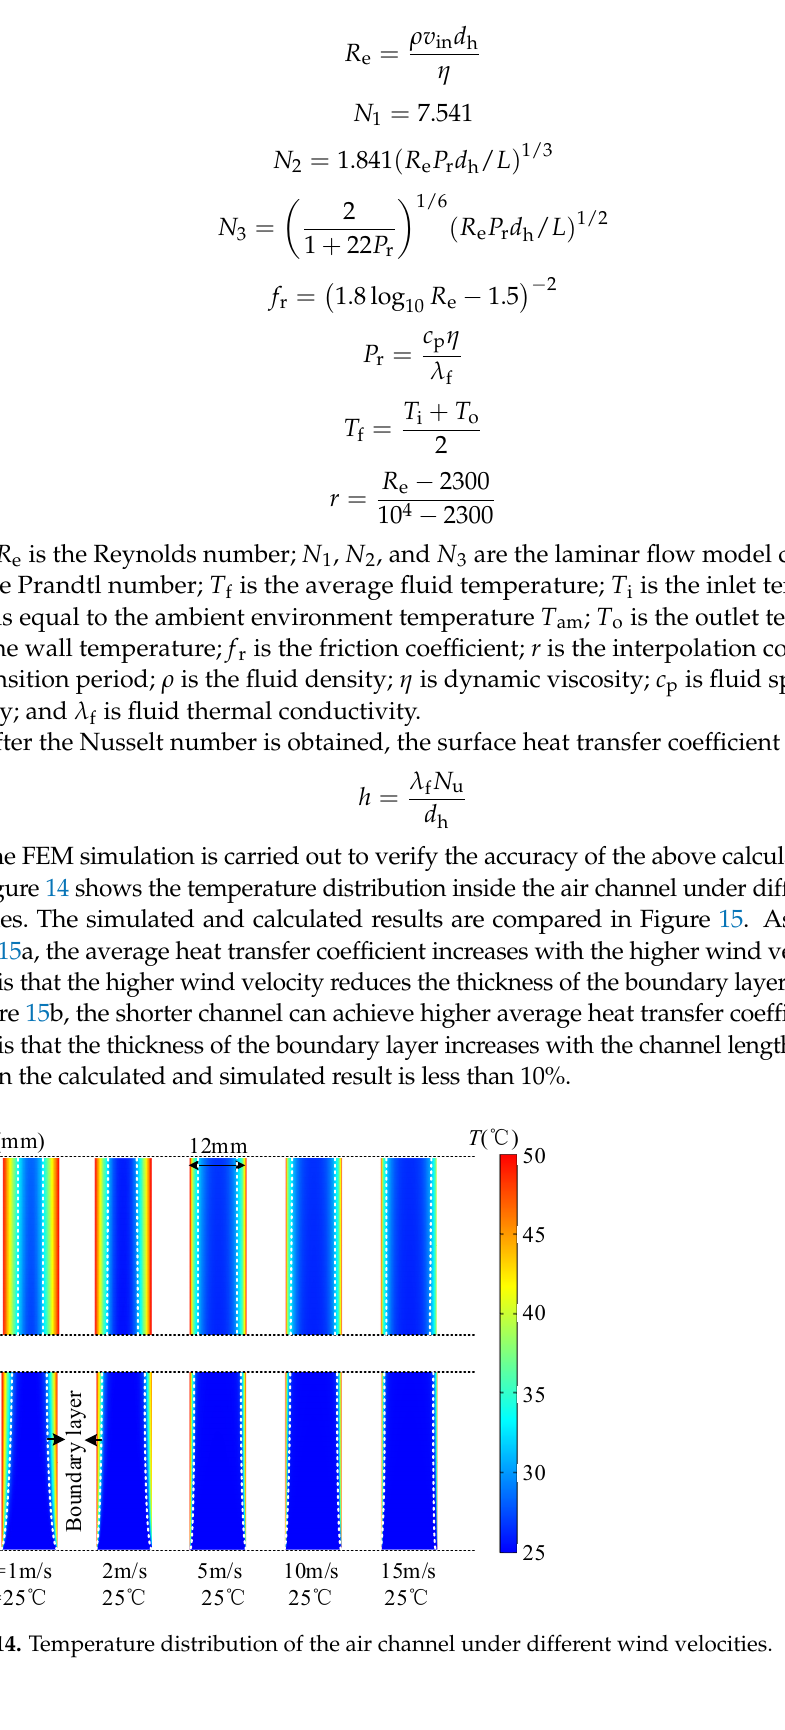
( b ) Figure 15. Comparison of the simulated and calculated heat transfer coefficients. ( a ) Different wind velocities; ( b ) different channel lengths. After obtaining the heat transfer coefficient, the convective thermal resistance can be obtained according to the Newton cooling formula of the internal convection. (